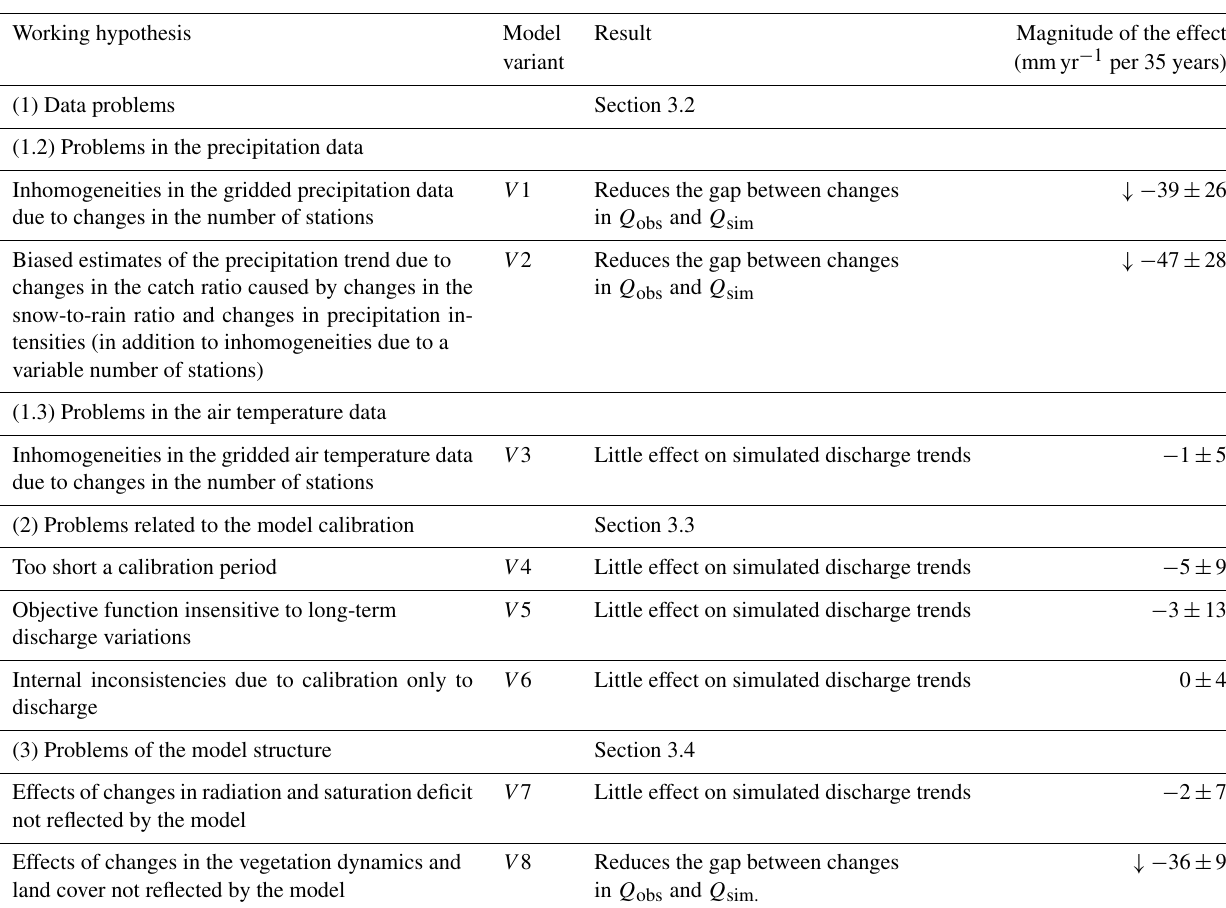
Table 5. Working hypotheses for potential causes of the divergence between observed and simulated discharge changes that were further analysed and the estimated magnitude of the effect on the gap between trends in Q obs and Q sim (mmyr − 1 per 35 years) over 1978–2013 as compared to the baseline model. This was calculated by deriving a series of the differences in annual discharge of the respective model variant compared to the baseline model (e.g. Q sim ,V 1 – Q sim ,V 0 ) for each catchment and then estimating trends. Uncertainties relate to standard deviations of the trend slope averaged over all